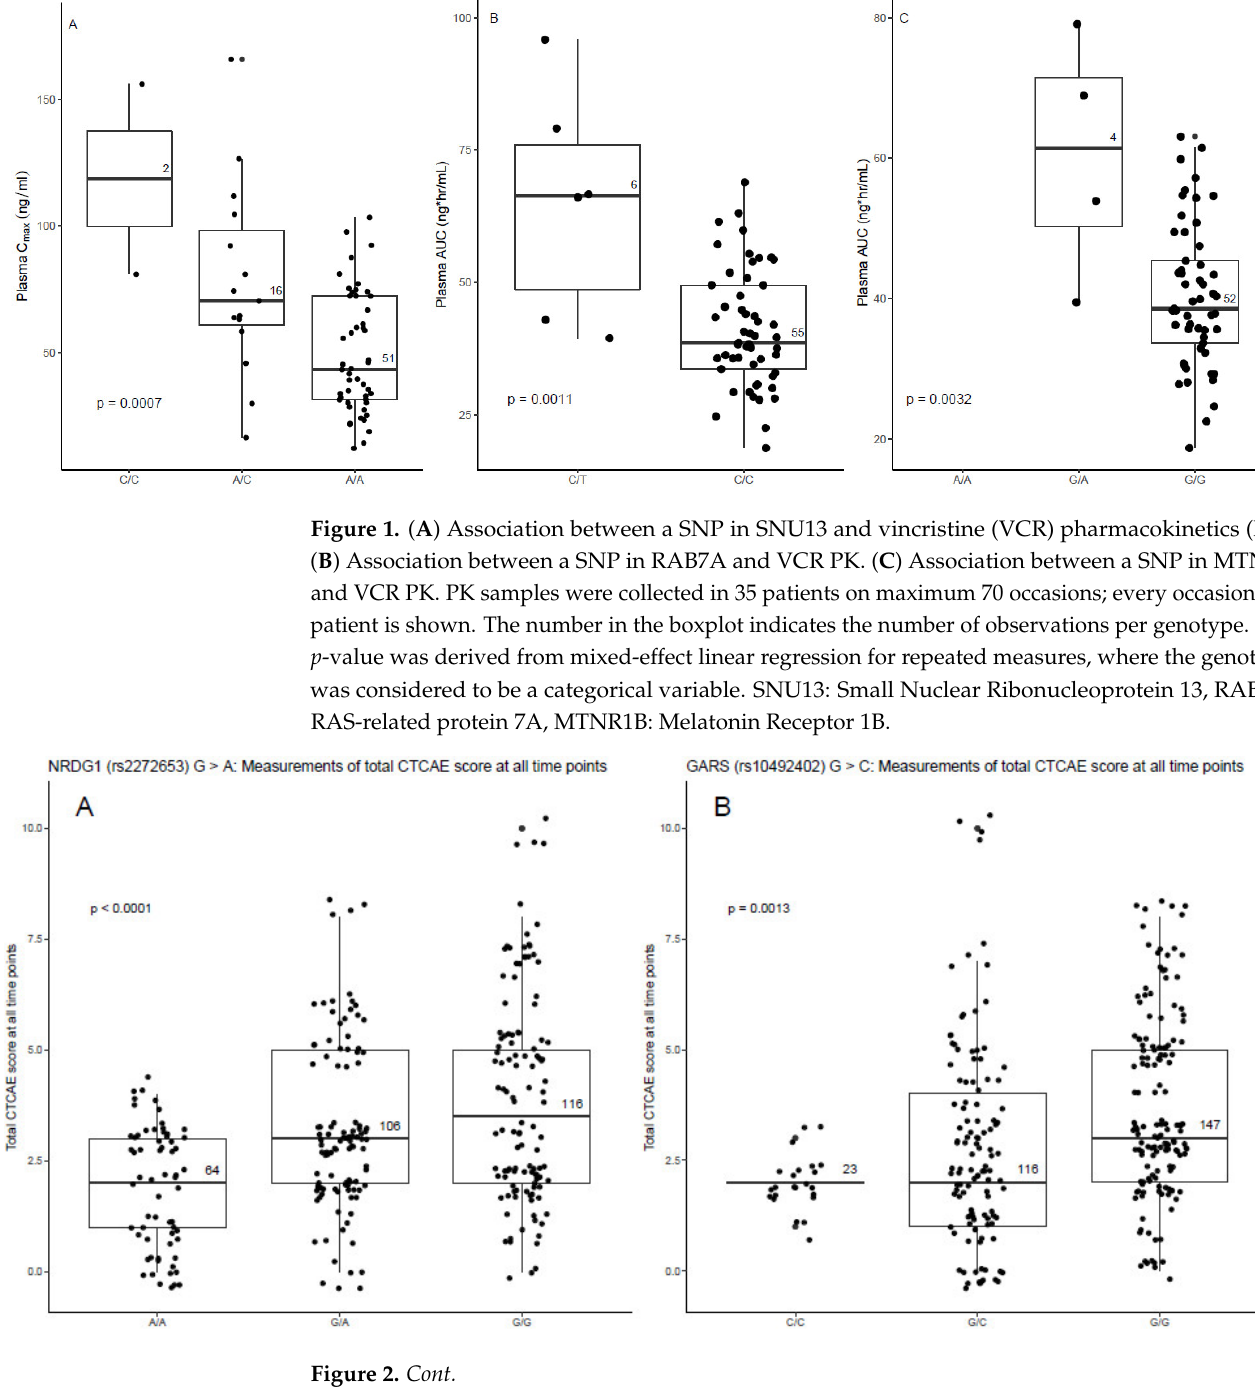
Figure 2. ( A ): Association between a SNP in NRDG1 and total Common Toxicity Criteria of Adverse Events (CTCAE) score. ( B ): Association between a SNP in GARS and total CTCAE score. ( C ): Association between a SNP in FGD4 and pediatric-modified Total Neuropathy Score (ped-mTNS). ( D ): Association between a SNP in CEP72 and ped-mTNS score. VIPN measurements were performed 1–5 times in 85 patients. Every VIPN measurement per patient across the time points is shown. The number in the boxplot indicates the number of observations per genotype. The p -value was derived from Poisson regression analysis for repeated measures, where the genotype was considered to be a categorical variable. NRDG1: N-Myc Downstream Regulated 1, GARS: Glycyl tRNA Synthetase, FGD4: FYVE, RhoGEF and PH Domain Containing 4, CEP72: Centrosomal Protein 72.